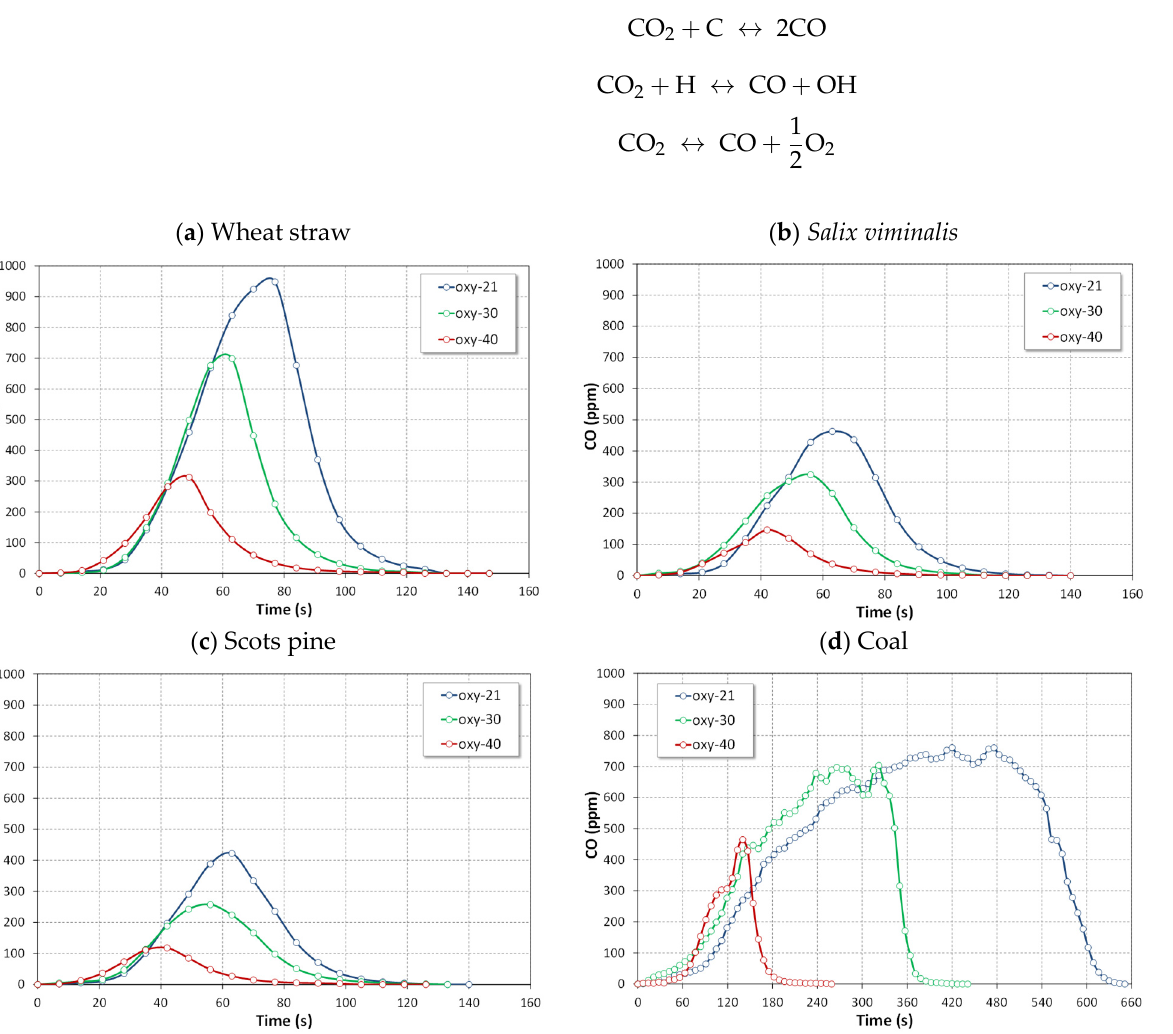
Figure 18. Influence of the oxygen concentration on total emissions of CO during combustion of biomass fuels. Open points represent combustion in air. Vertical bars represent standard deviation.